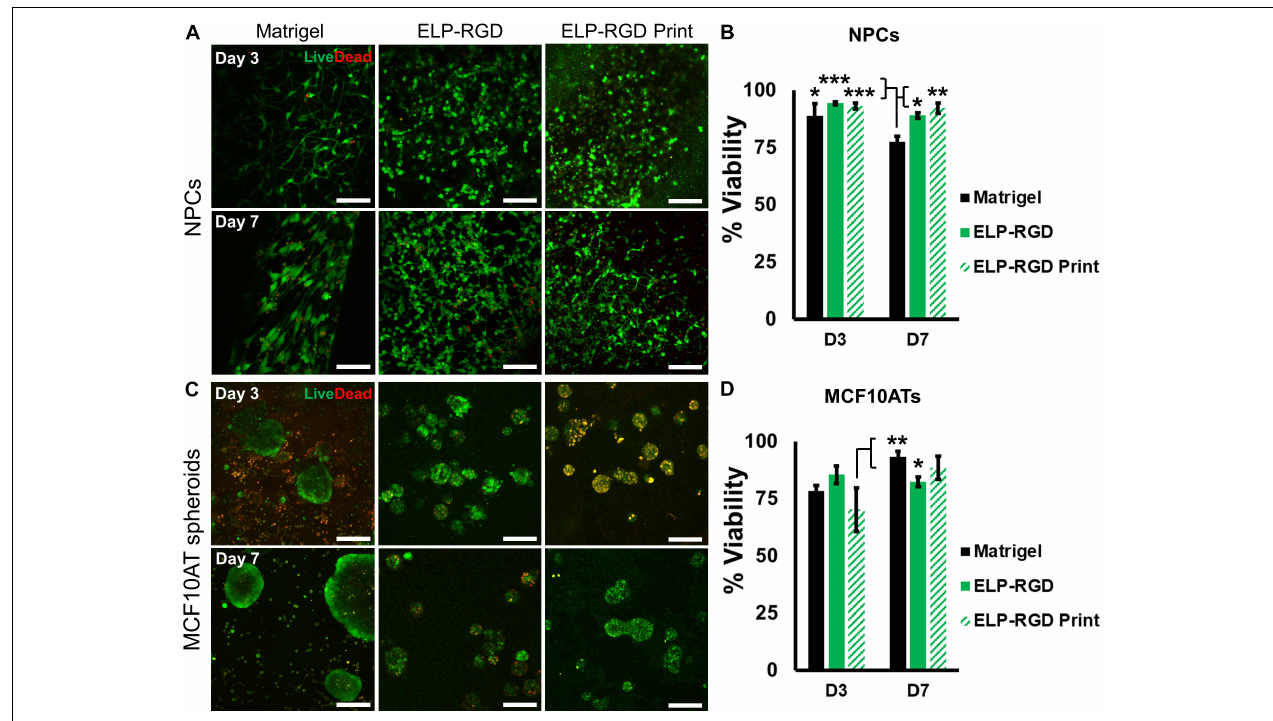
FIGURE 4 | Viability of dissociated cells and spheroids with and without bioprinting. Live cells are stained with calcein (green) and dead cells are stained with ethidium homodimer-1 (red). (A) Live/Dead staining of murine neural progenitor cells (NPCs) on days 3 and 7 within Matrigel (not bioprinted), 3 wt% ELP-RGD (not bioprinted), and 3 wt% ELP-RGD after DoD bioprinting. Scale bars represent 100 µ m. (B) Quantified viability of NPCs at days 3 and 7. Statistical significance marked as * p < 0.05, ** p < 0.005, and *** p < 0.001 ( N = 3, One-way ANOVA with Tukey’s post hoc test). (C) Live/Dead staining of human premalignant breast epithelial cell spheroids (MCF10ATs) in Matrigel (not bioprinted), 3 wt% ELP-RGD (not bioprinted), and 3 wt% ELP-RGD after DoD bioprinting at days 3 and 7. Scale bars represent 100 µ m. (D) Quantified viability of MCF10ATs at days 3 and 7. Statistical significance marked as * p < 0.05, and ** p < 0.005 ( N = 3, One-way ANOVA with Tukey’s post hoc